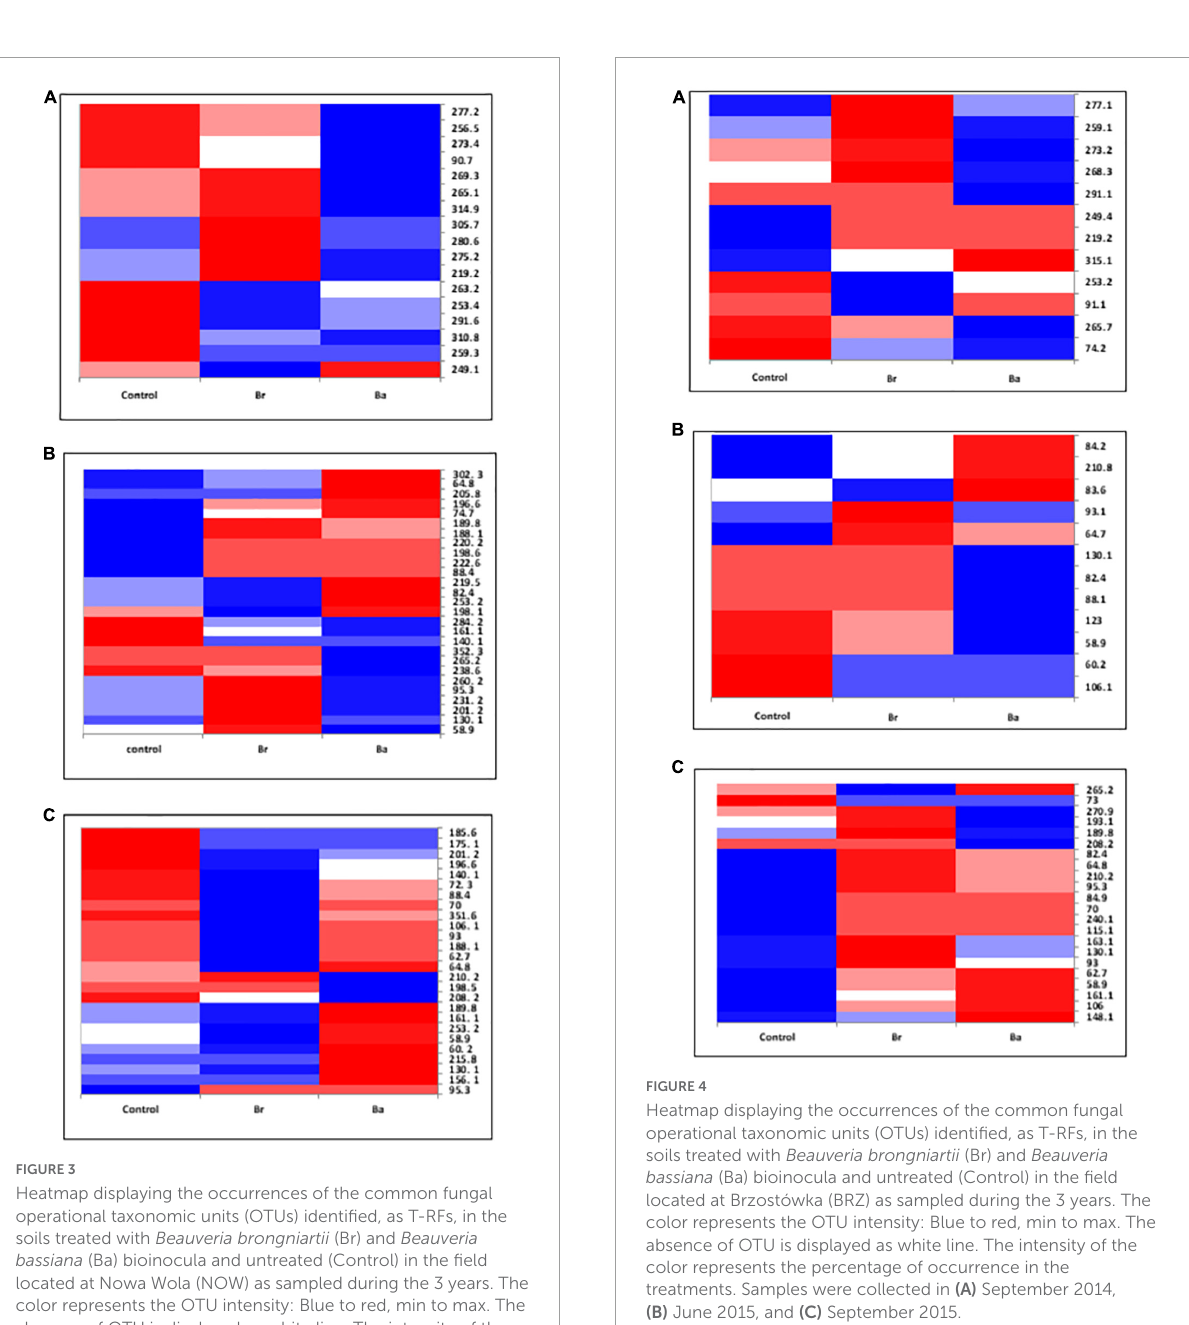
FIGURE4 Heatmap displaying the occurrences of the common fungal operational taxonomic units (OTUs) identified, as T-RFs, in the soils treated with Beauveria brongniartii (Br) and Beauveria bassiana (Ba) bioinocula and untreated (Control) in the field located at Brzostówka (BRZ) as sampled during the 3 years. The color represents the OTU intensity: Blue to red, min to max. The absence of OTU is displayed as white line. The intensity of the color represents the percentage of occurrence in the treatments. Samples were collected in (A) September 2014, (B) June 2015, and (C) September